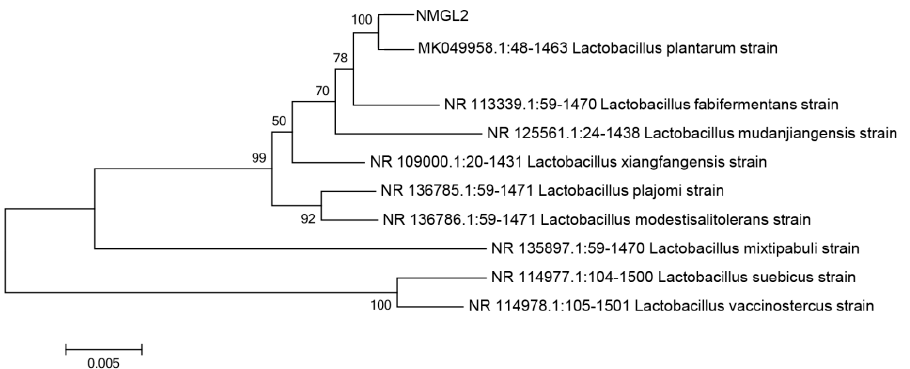
Figure 1. Evolutionary tree of Lpb. plantarum NMGL2.